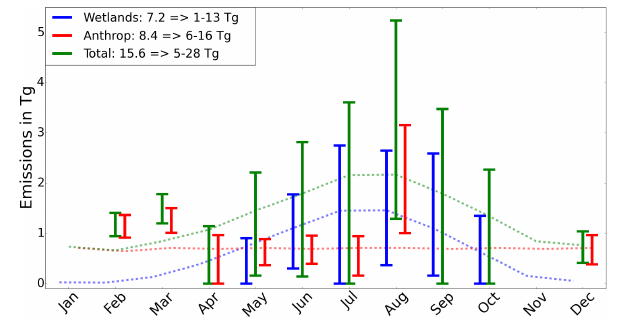
Figure 6. Time series of the posterior emissions on the Siberian lowlands. The emissions are reported in TgCH 4 for each month. The correction factors computed on the constrained regions (in Sect. 5) are extrapolated to the Siberian lowlands (see Fig. 1). The extrapolation is carried out only when more than 20% of the prior emissions are constrained. The error bars depict the tolerance interval of posterior emissions. The dotted lines denote the prior fluxes. The yearly prior emissions and posterior tolerance intervals in TgCH 4 are noted in the